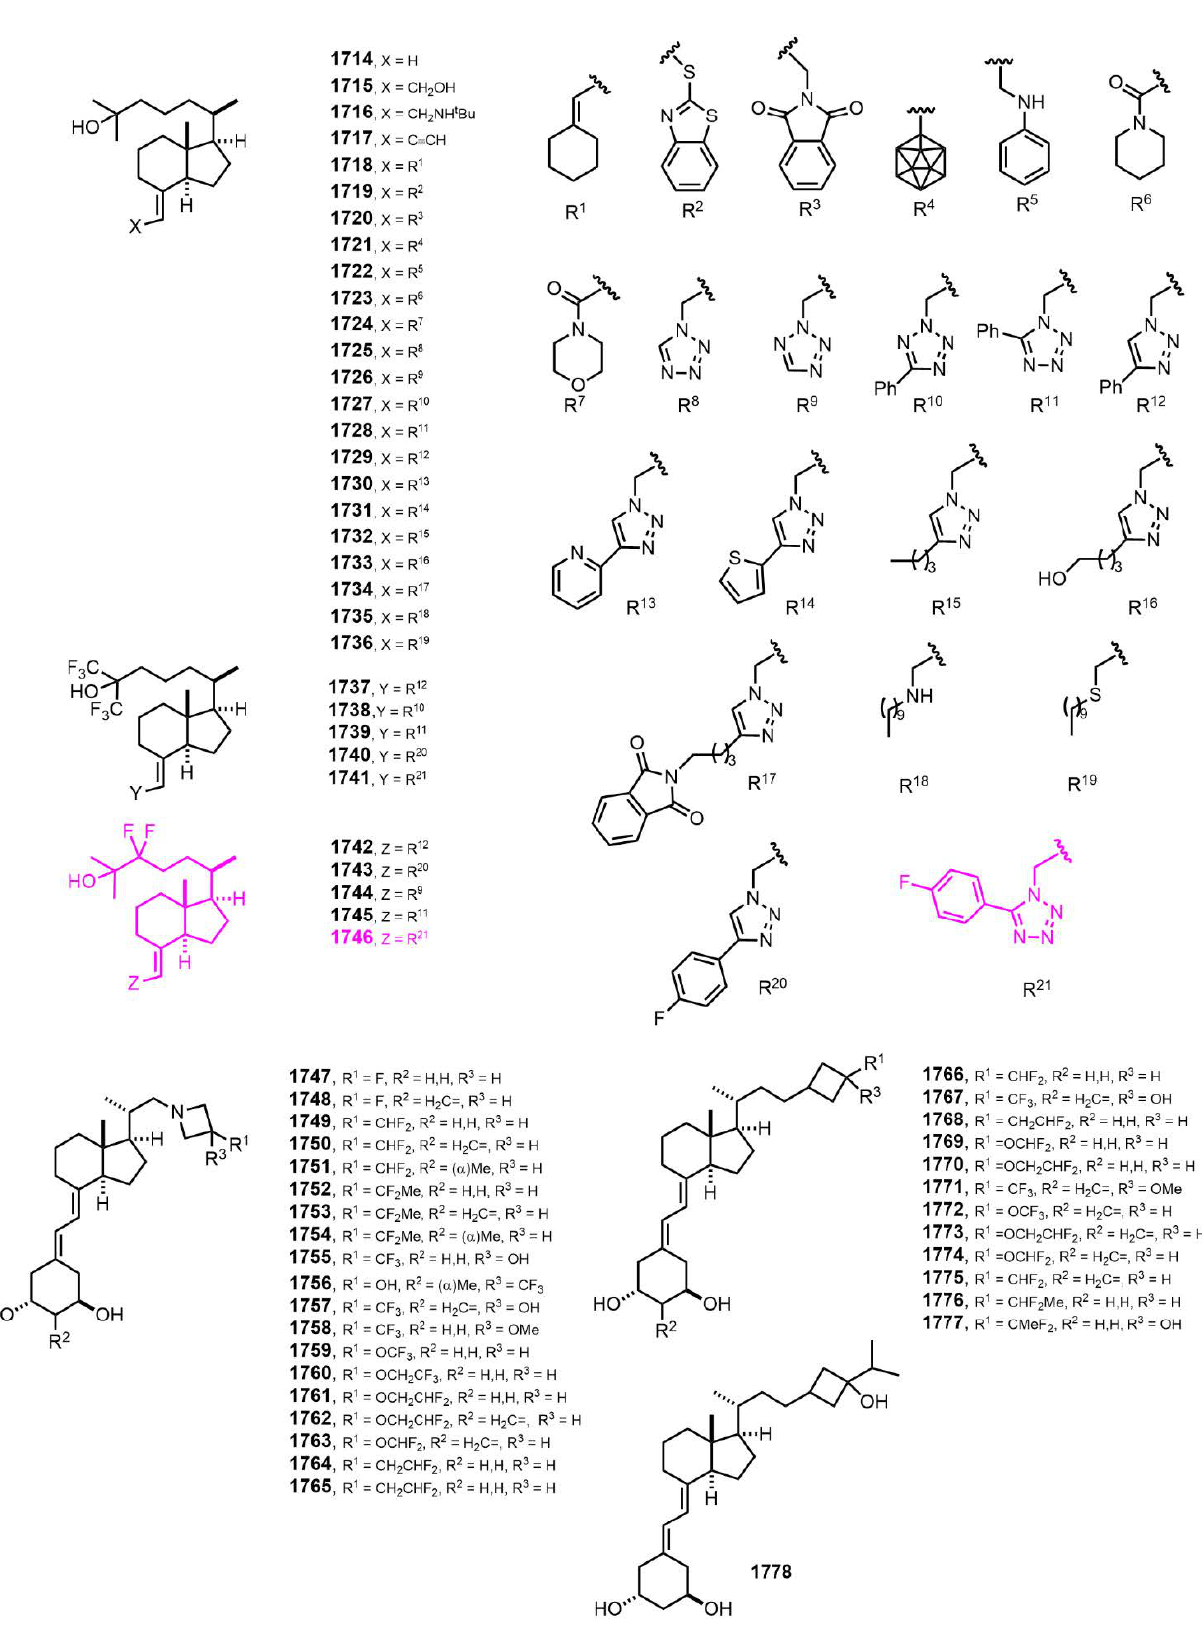
Figure 31. (2021-2022) [390-392].